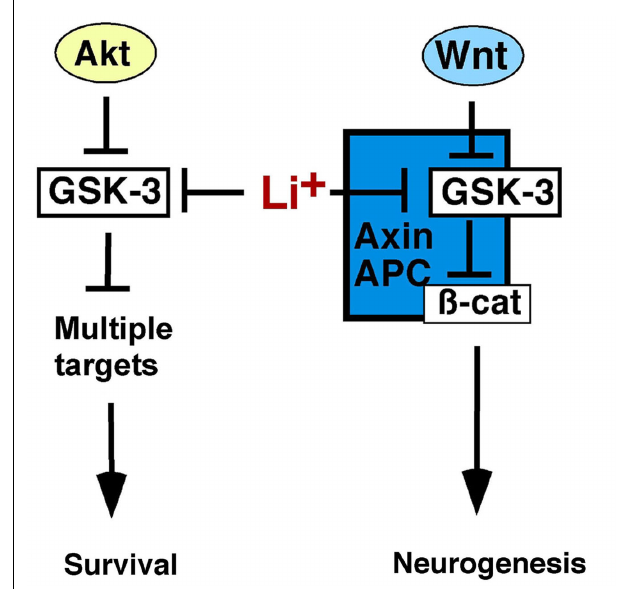
FIGURE 1 | Glycogen synthase kinase-3 regulatesWnt and Akt-dependent signaling. Growth factors, including neurotrophins, activate Akt, which phosphorylates, and inhibits GSK-3 allowing activation of downstream effectors to promote cell survival. Both Akt and GSK-3 have multiple targets not shown here for the sake of clarity.Wnts inhibit GSK-3 within the Axin complex stabilizing β -catenin, which activatesWnt target genes, and promotes neurogenesis. Axin-associated GSK-3 is not regulated by N-terminal phosphorylation and is thus distinct from Akt-regulated GSK-3, and both pools are inhibited by lithium.Thus lithium may stimulate neurogenesis by activatingWnt/ β -catenin signaling and enhancing cell